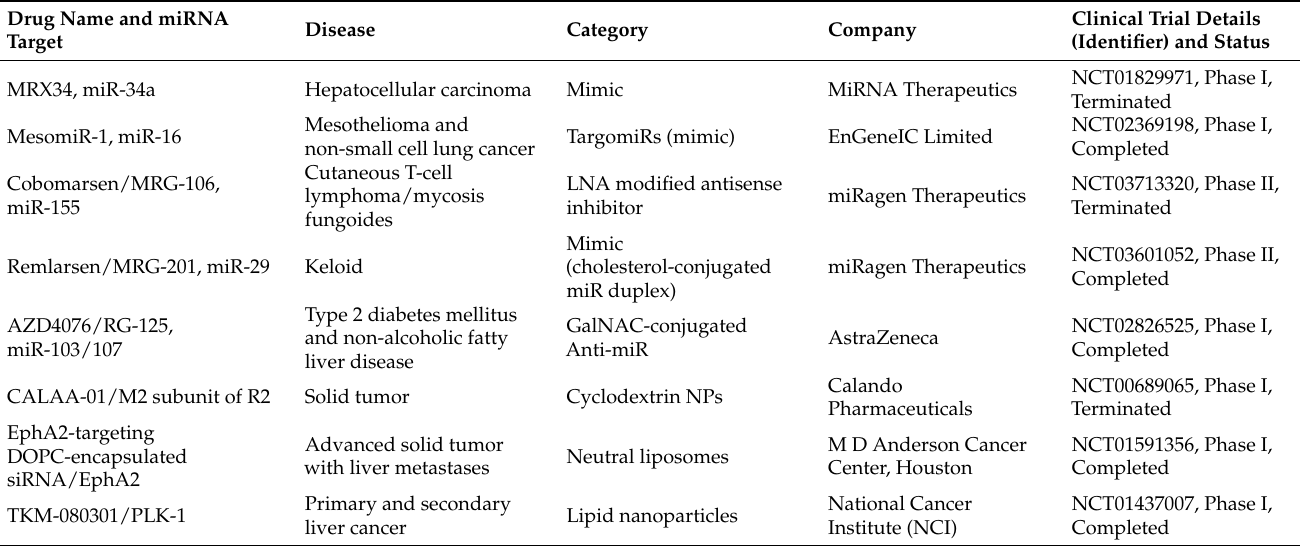
Table 3. Clinical trials that have been started for miRNA- and siRNA-based therapeutics. Data based on the clinical trial